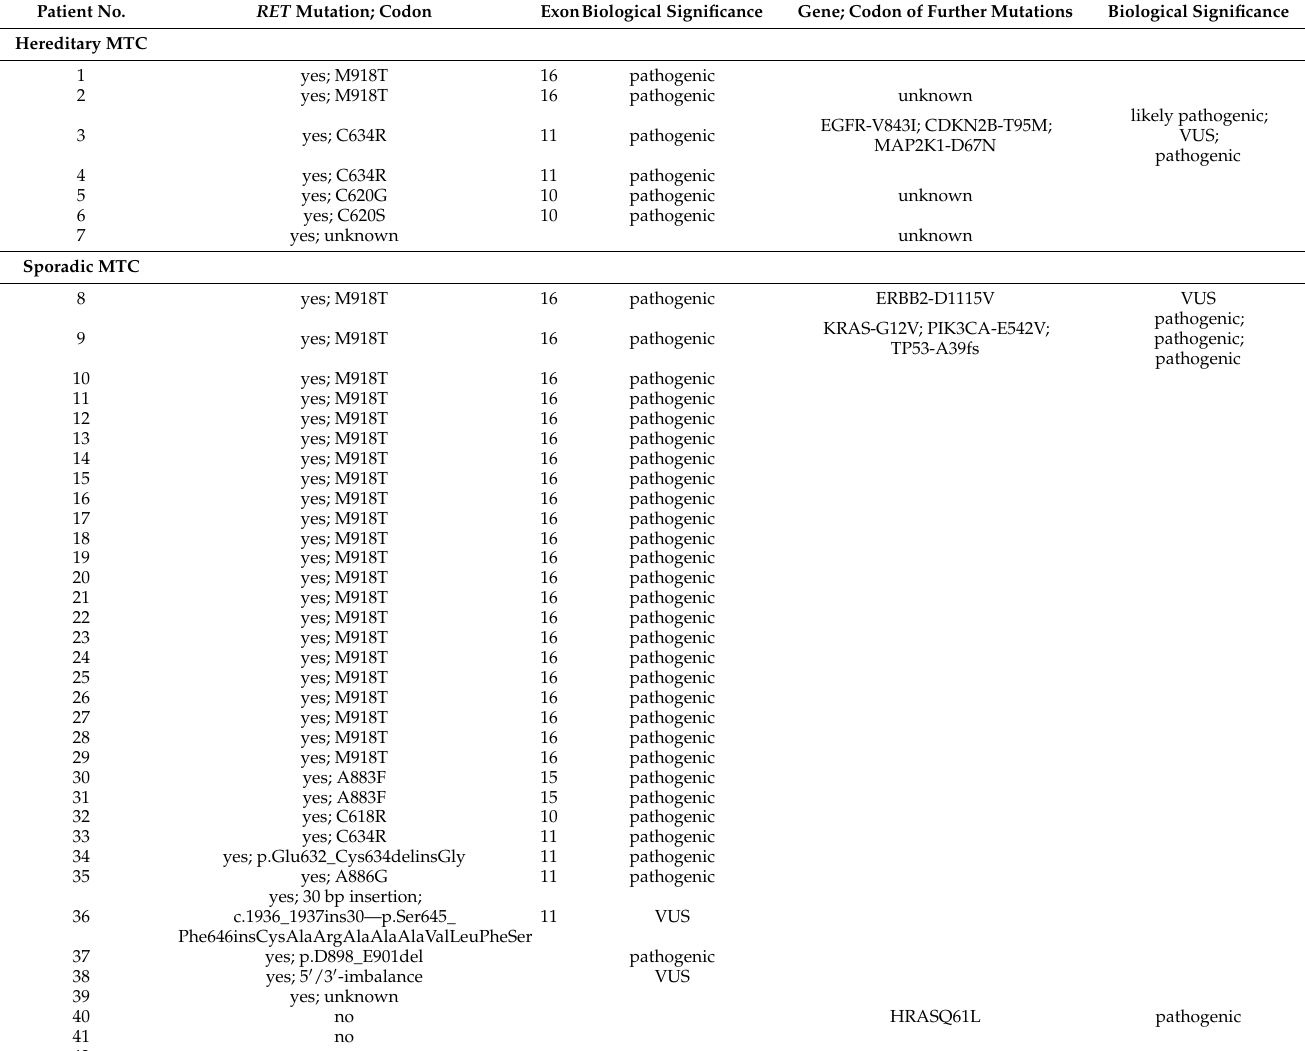
Table A1. Genetic features of the study